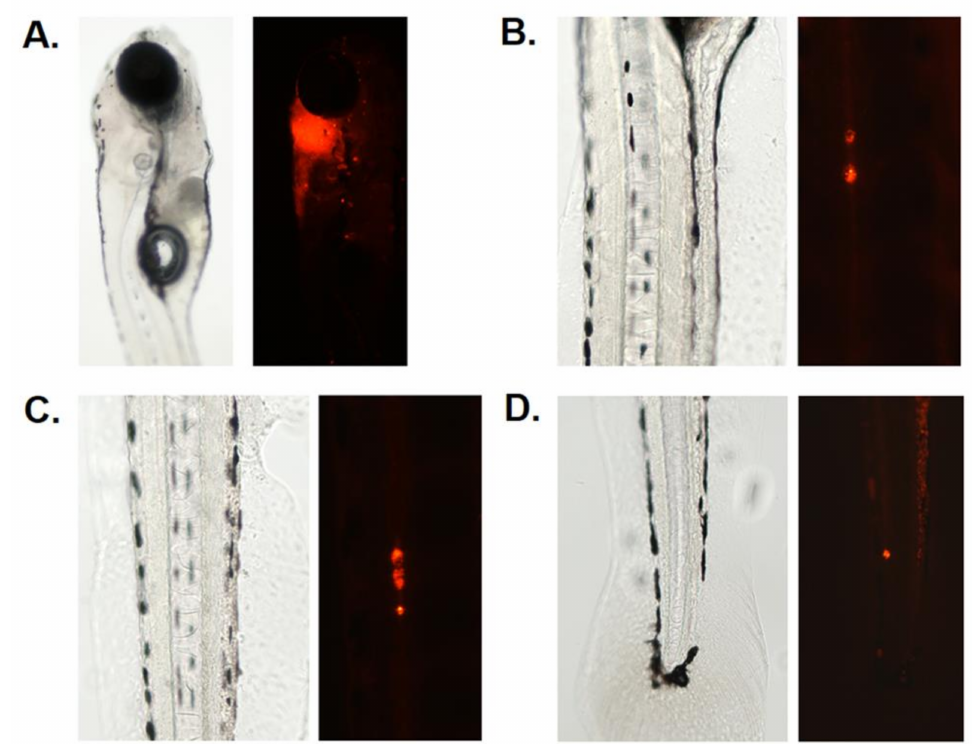
Figure 2. Fluorescent tracking of secondary tumor migration in zebrafish MDA-MB-231 TNBC xenografts. ( A ). Bright-field view of a 6 dpf AB zebrafish larvae (left) and fluorescent channel image of larvae (right) microinjected with DiI-treated MDA-MB-231 TNBC cells at 4 dpi. ( B – D ). Bright-field view (left) and fluorescent view (right) of caudal sections of migrated MDA-MB-231 TNBC cells in the spinal cord of AB zebrafish larvae at 8 dpi. ( B ): anterior; ( C ): medial; ( D ): posterior caudal section of the zebrafish